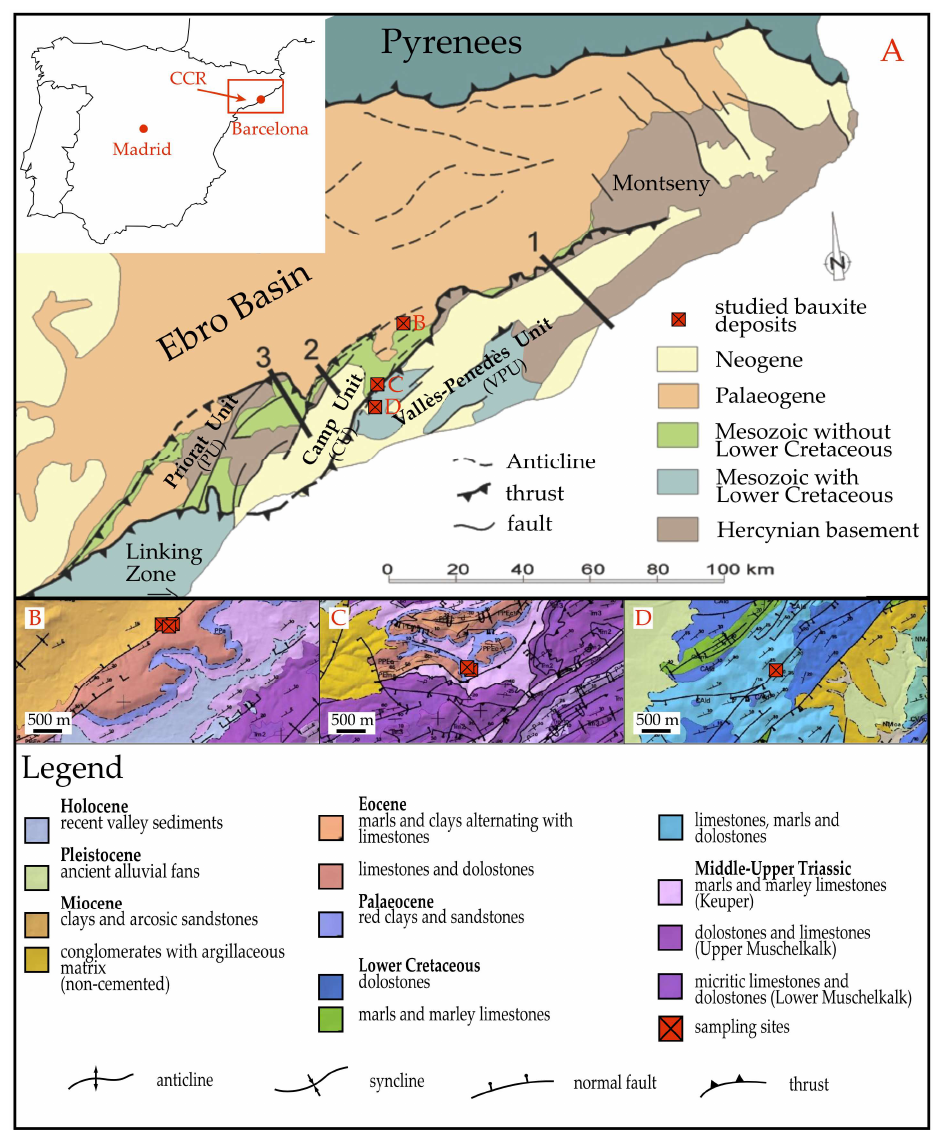
Figure 1. ( A ) Simplified geological map of the Catalan Coastal Range (CCR) modified from [42] and